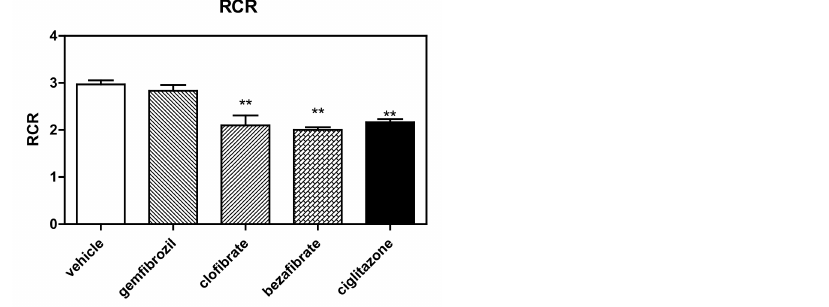
Figure 2. RCR of permeabilized HepG2 cells treated with different PPAR ligands. ** p < 0.01.